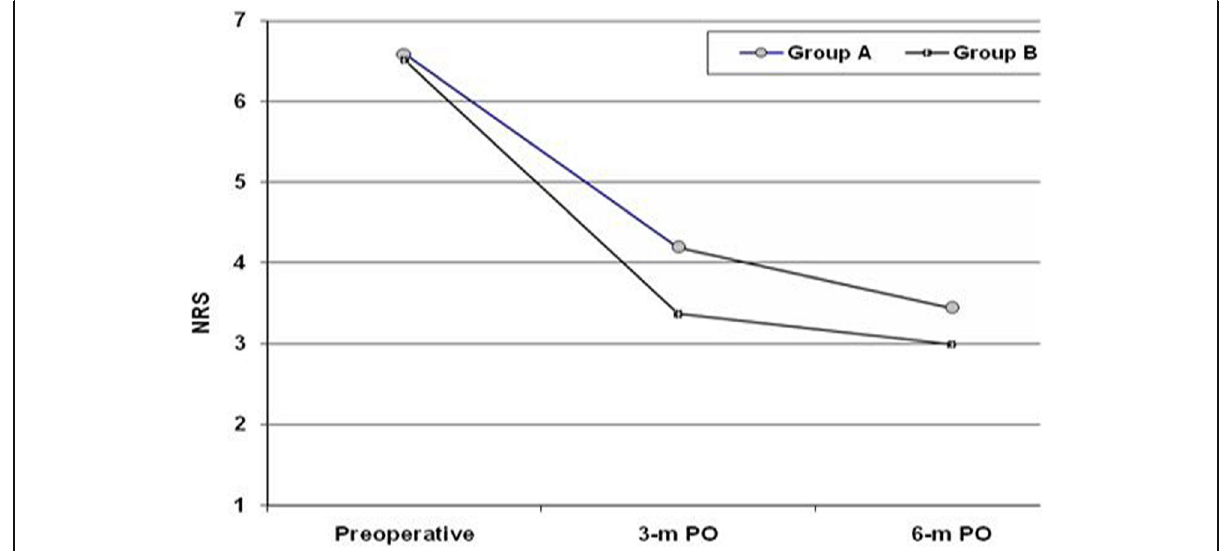
Fig. 5 Mean NRS determined at score at 3 and 6 months post-operative in patients of both groups compared to pre-operative